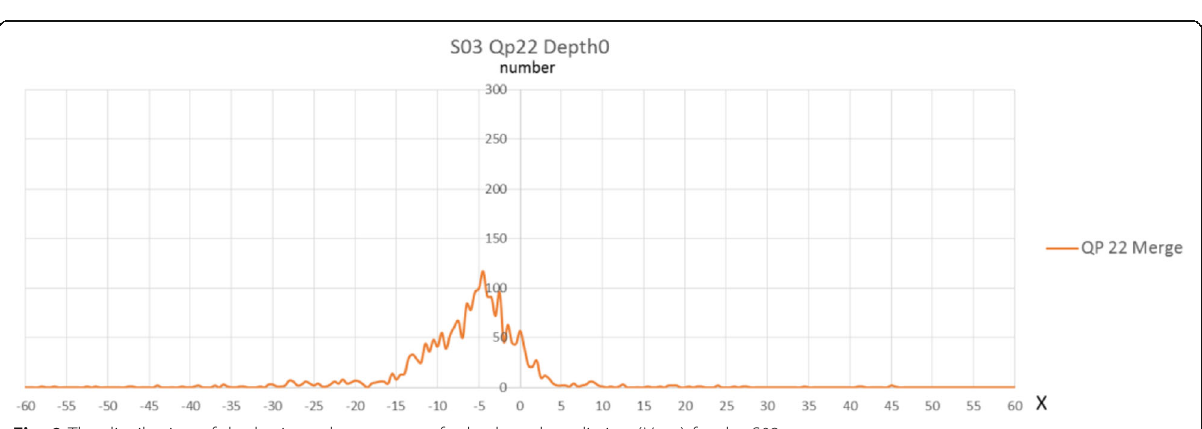
Fig. 9 The distribution of the horizontal component for backward prediction ( V X _ L 1 ) for the S03